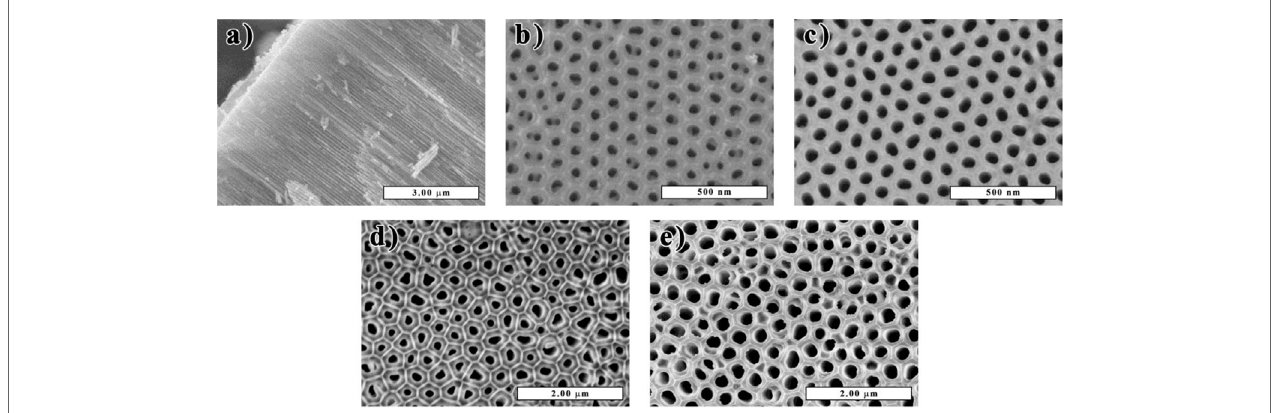
FigUre 2 | seM micrographs of the cross section (a) and bottom and top sides of the caaO (B,c) and caaO-P (D,e) films